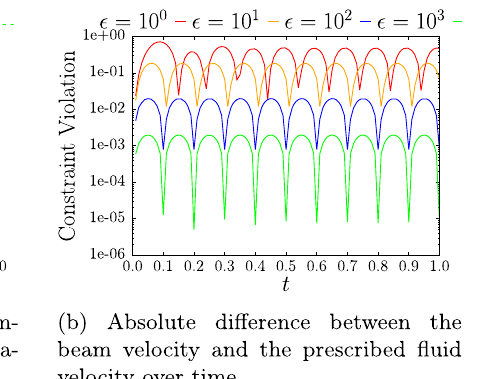
Inthisexample,thefluidisagainassumedtobecontainedinahexahedronofdimensions 1 × 1 × 3 as introduced in “Fixed obstacle immersed in a fluid channel”. Only now all DoFs in channel direction are set to be free and a velocity of zero is prescribed in both other directions, leading to a pseudo one-dimensional setup. In order to analyze the time- dependent behavior of the beam in dependence on the penalty parameter, an oscillatory inflow